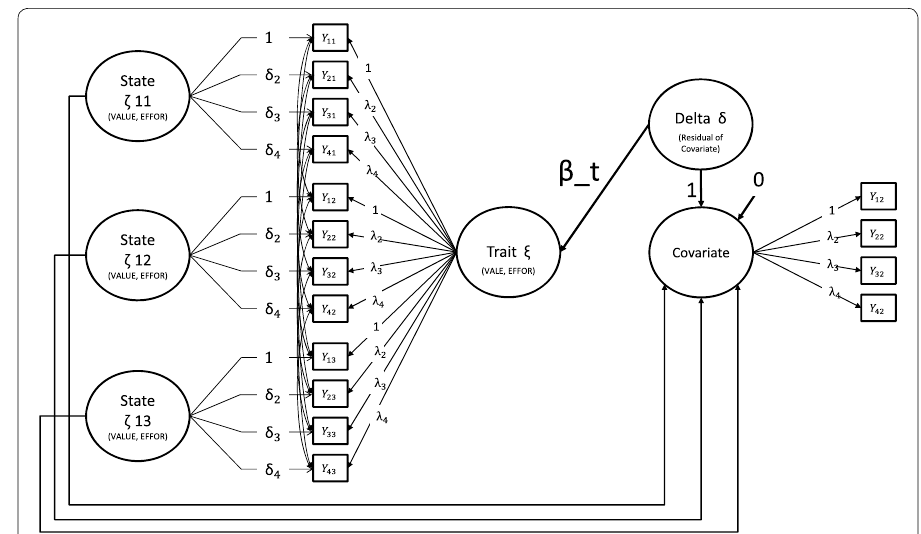
Fig. 3 Bifactor model using the residual approach to predict the trait factor. VALUE Subjective test value = dimension of the test motivation construct. EFFOR Effort dimension of the test motivation construct. 11, = 12, 13 grade 11, grade 12, grade 13. The association β _s13 (states at grade 13) is depicted as dashed line = indicating that this association is not investigated in the present study. β _t (trait) indicates the associations of interest. The correlated uniqueness approach (item/method-specific correlations over time) is indicated by vertical curved (unlabelled)